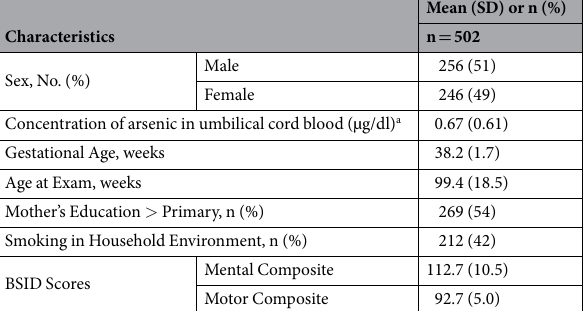
the rs35418153 minor allele (G) was also associated with a decrease in mental composite score of 2.47. However, these two SNPs did not show a significant interaction with As exposure. Region-based association testing revealed a significant association between mental composite score and the main effects of SNPs in miR-124-3 (Table 3).